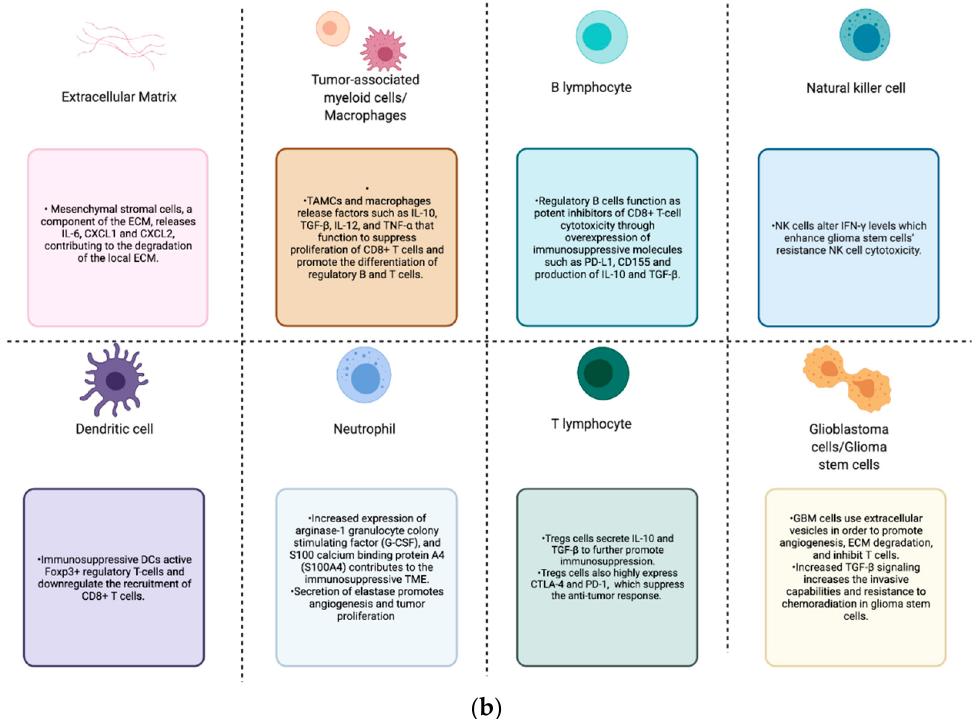
Figure 1. ( a ) GBM tumor microenvironment and its components; ( b ) components of the GBM TME and their contributions to the immunosuppression, proliferation, invasion, and treatment resistance seen in these tumors.